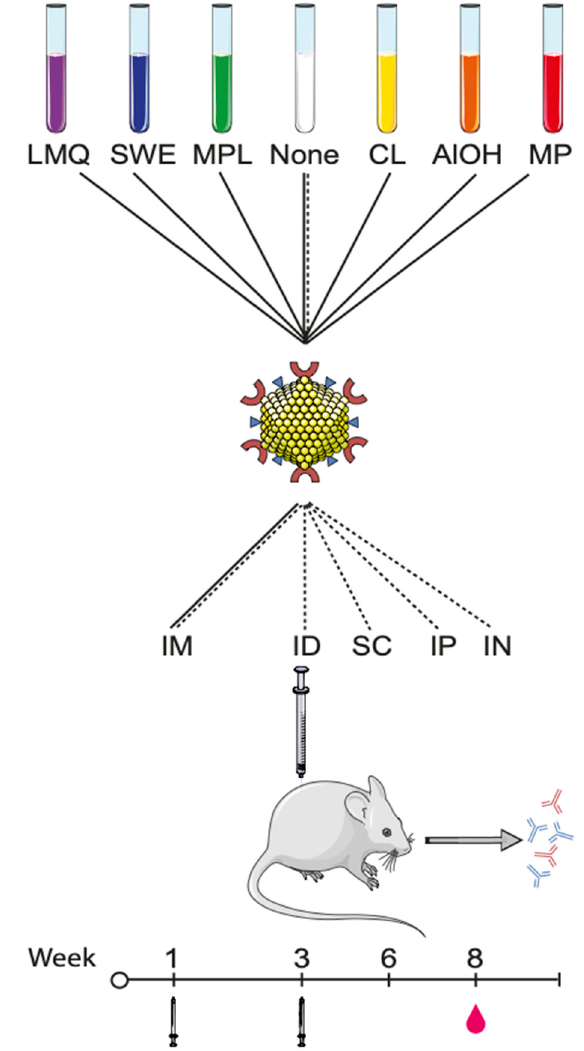
Figure 1. Schematic overview of the adjuvant formulations, vaccination routes, and timepoints employed: SpyCatcher-AP205-L2 CLP (SpyCatcher—red “C” shapes, L2 RG-1 peptide epitope—blue triangles, and CLP structural proteins—yellow spheres) were formulated in six extrinsic adjuvants, including liposomes/MPL/QS21 (LMQ, purple), squalene water emulsion (SWE, blue), monophosphoryl lipid A (MPL, green), cationic liposomes (CL, yellow), aluminum hydroxide (AlOH, orange), or Microparticles (MP, red) or without extrinsic adjuvants (none, white). The mice were immunized intramuscularly (IM) with all CLP formulations in a prime-boost regimen at weeks 1 and 3. Blood was drawn on week 8 (i.e., 5 weeks after last immunization). In a separate study, SpyCatcher-AP205-L2 was formulated without adjuvants (none) and immunized in a prime boost regiment via different routes of injections, specifically IM, intraperitoneally (IP), subcutaneously (SC), intradermally (ID), and intranasally (IN). The graphics of the mouse, the CLP, and reagent tubes have been modified from Servier Medical ART under a creative commons license (https://creativecommons.org/licenses/by/3.0/legalcode).